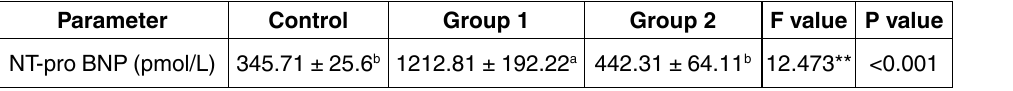
table 2. Serum NT-pro BNP Parameter